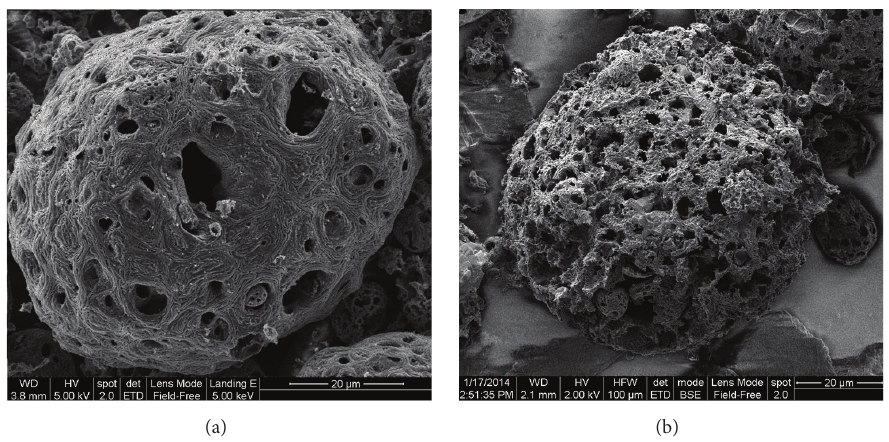
Figure 2: SEM images of OFA (a) before and (b) after chemical